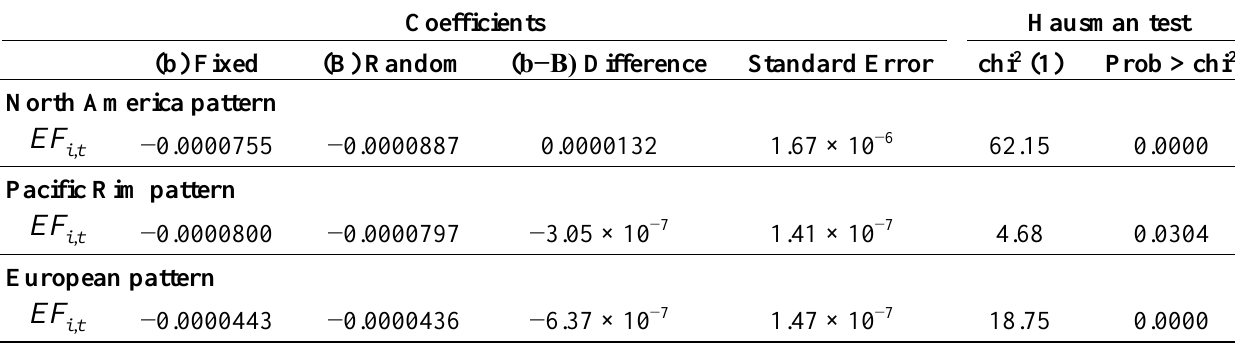
Table 3. The results of the Hausman